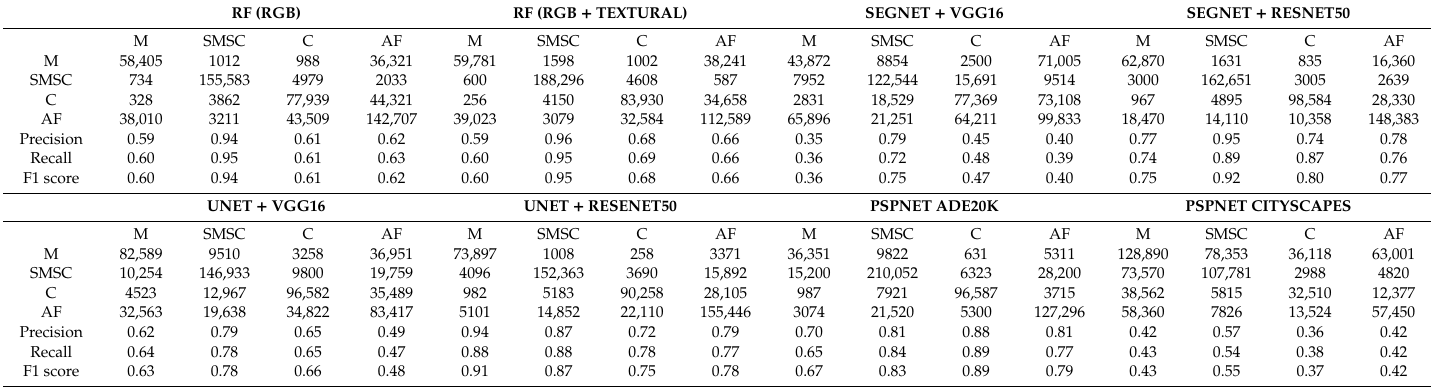
Table 4. Confusion matrix per community per segmentation model (ML and